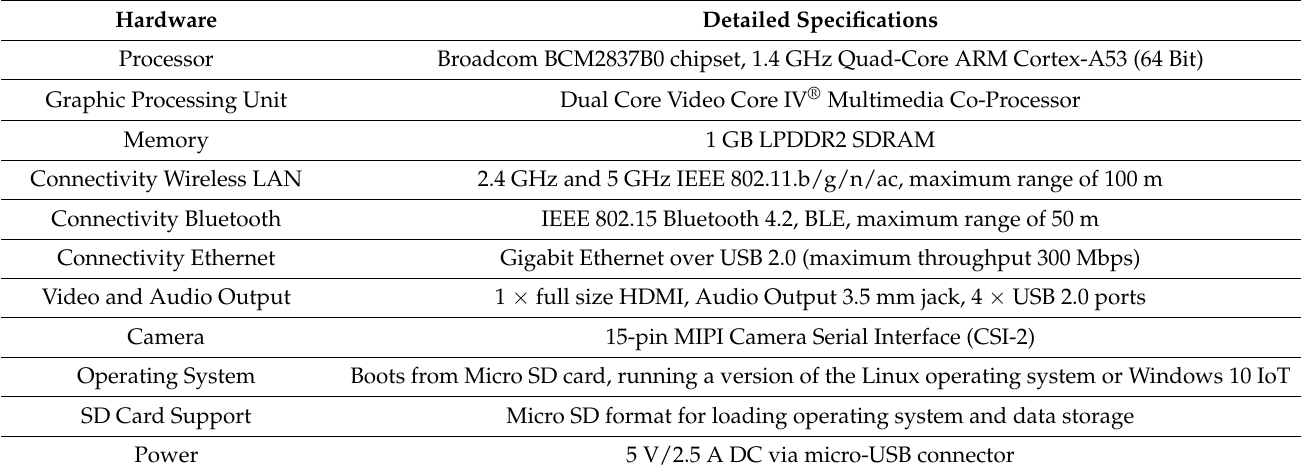
Table 4. Full description of the smart